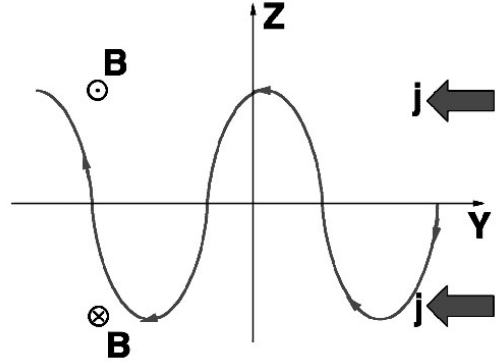
Fig. 1. Ion trajectory in the vicinity of the neutral layer. Associated electric current has two maxima at the distances z of the order of ion gyroradius and is zero at z =0 ( B x